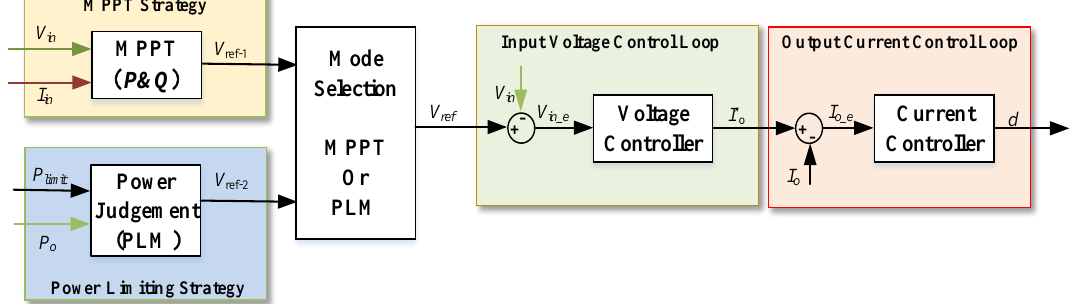
Figure 6. Basic control strategy of the DC/DC converter.